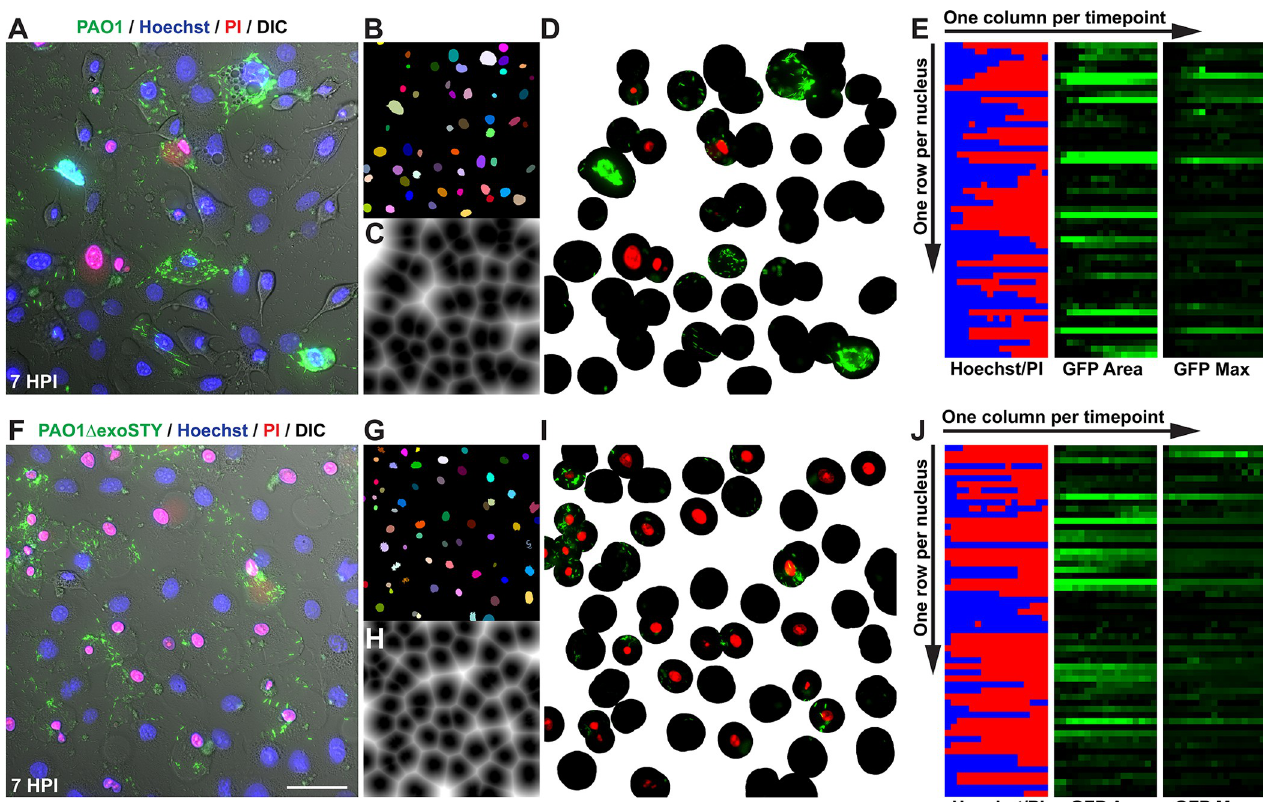
Fig 5. Time-lapse imaging computational analysis. For each time-lapse field for PAO1 (A) versus PAO1 Δ e xoSTY (F) , individual nuclei were segmented into ultimate points, tracked by mTrack2 plugin, and assigned an ID number (B) versus (G) respectively. Nuclei were excluded if tracks were not present in all frames. A distance map was drawn from each nucleus to designate its cytoplasmic area (C) versus (H) . A distance limit of 50 was determined empirically based on average corneal epithelial cell size (D) versus (I) . Some bacteria were excluded from analysis when located further from the nucleus but prevented from being assigned to neighboring cells using this limit. Measurements were recorded as a series of TIF images with one row per nucleus, and one column per timepoint (E) versus (J) . The ratio of PI to Hoechst signal was measured for each nucleus. GFP area, max intensity, and median intensity were measured within each cell’s defined area. A value to indicate cell death was determined empirically based on value changes when PI became visible in corresponding images, and background values for GFP area and GFP max were determined using uninfected controls and fields where bacteria were not present.